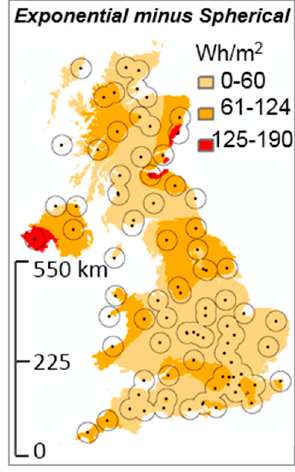
Figure A4. Difference between the exponential and spherical models of hourly global irradiation for 11:00 a.m. on 1 January 2012.